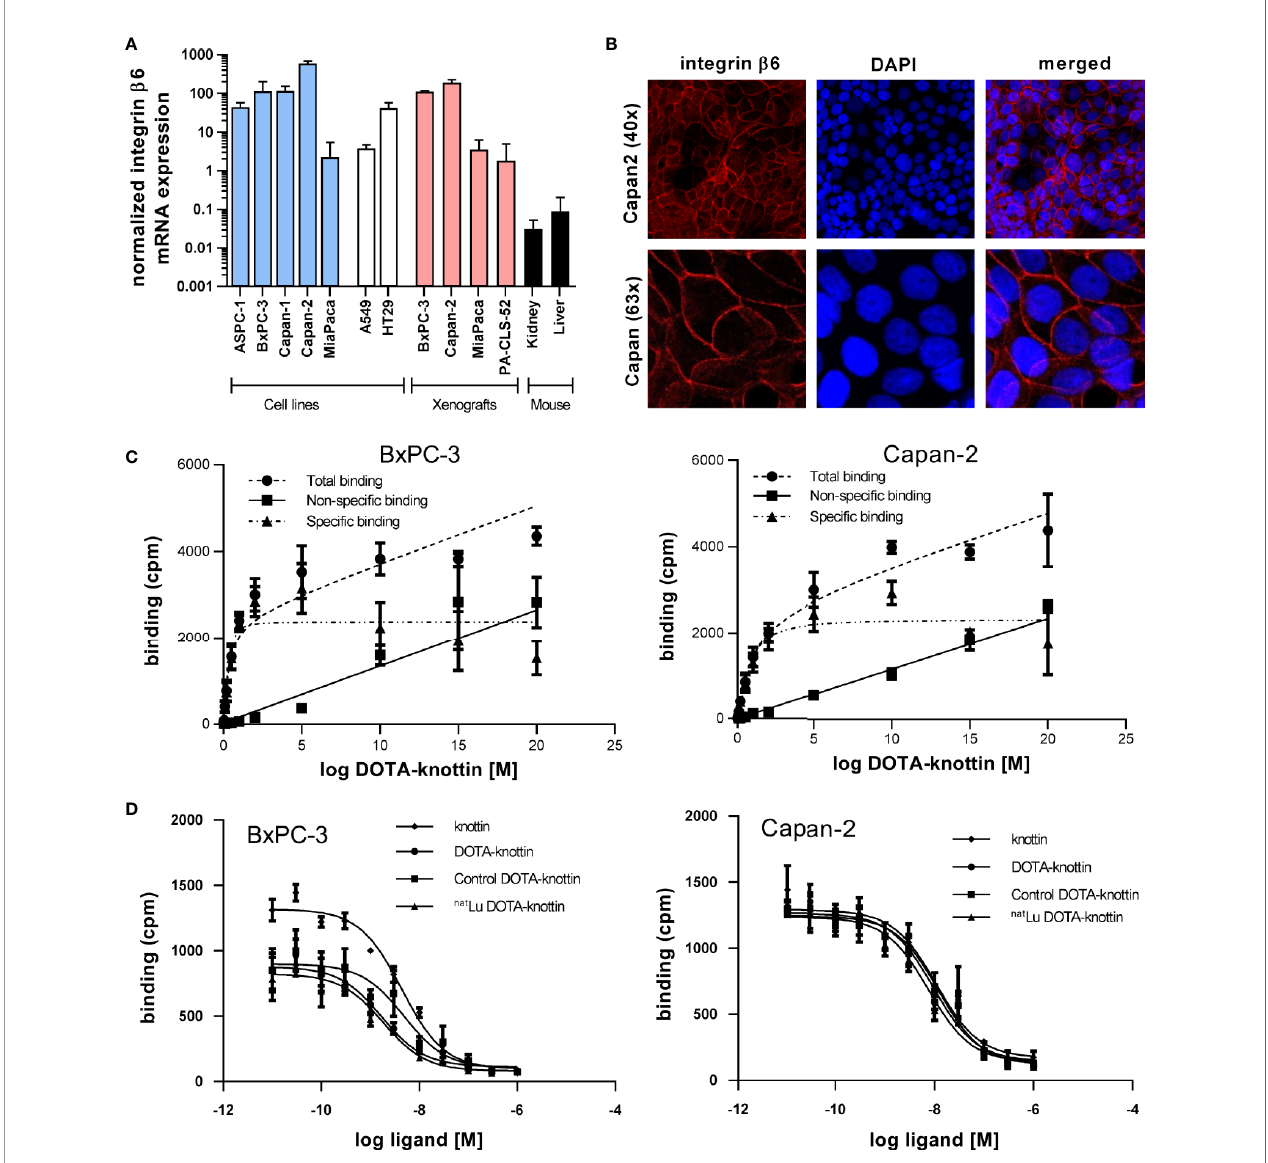
FIGURE 1 | Integrin b 6 mRNA, protein localization, binding sites and tracer af fi nity. (A) Integrin b 6 mRNA was measured by RT-qPCR in human cell lines of different origin, xenografts and mouse kidney and liver. Graphs represent normalized b 6 mRNA expression. (B) Fluorescence images show staining of integrin b 6 (antibody, red) and nucleus (TOTO-3, blue) in Capan-2 cells. (C) Dissociation constant (K d ) and number of binding sites per cell were determined in BxPC-3 and Capan-2 cells using a saturation binding assay with 125 I-DOTA-integrin a v b 6 knottin. (D) A competition binding assay using 125 I-DOTA-integrin a v b 6 knottin was performed to derive the inhibitory constant (K i ) of DOTA-knottin in both cell lines. The binding curves show tracer displacement by increasing concentrations of unlabeled knottin, DOTA-knottin (DOTA-integrin a v b 6 knottin), control-DOTA-knottin and nat Lu-DOTA-knottin. For the latter two, DOTA-integrin a v b 6 knottin was either complexed with natural lutetium ( nat Lu-DOTA-knottin) or treated the same but without the metal ion (control-DOTA-knottin). Data represent mean ± S.E.M (3 ≤ n ≤ 4).